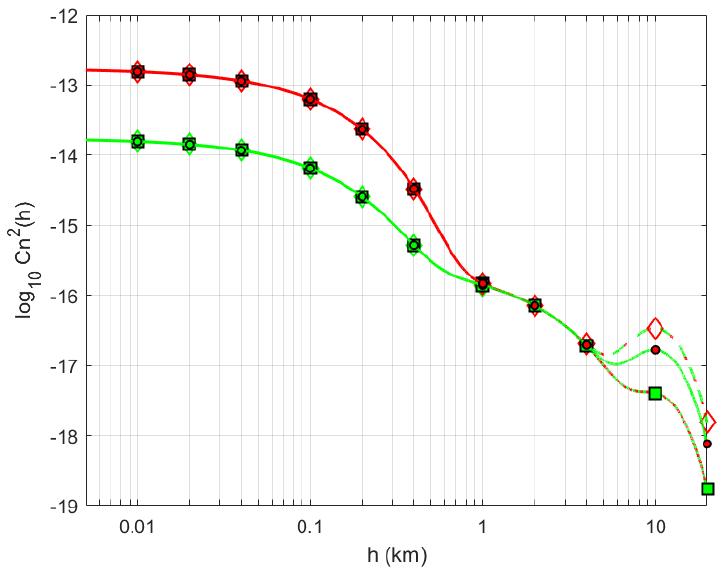
Figure 5. Refractive index structure C 2 n ( h ) along the slant path for the H-V day model as a function of the altitude. Red lines: A 0 = 1.7 × 10 − 13 m − 2/3 . Green lines: A 0 = 1.7 × 10 − 14 m − 2/3 . Wind speed: v = 10 m/s (dotted lines with squares); v = 21 m/s (solid-lines with circles); and v = 30 m/s (dashed lines with diamonds).